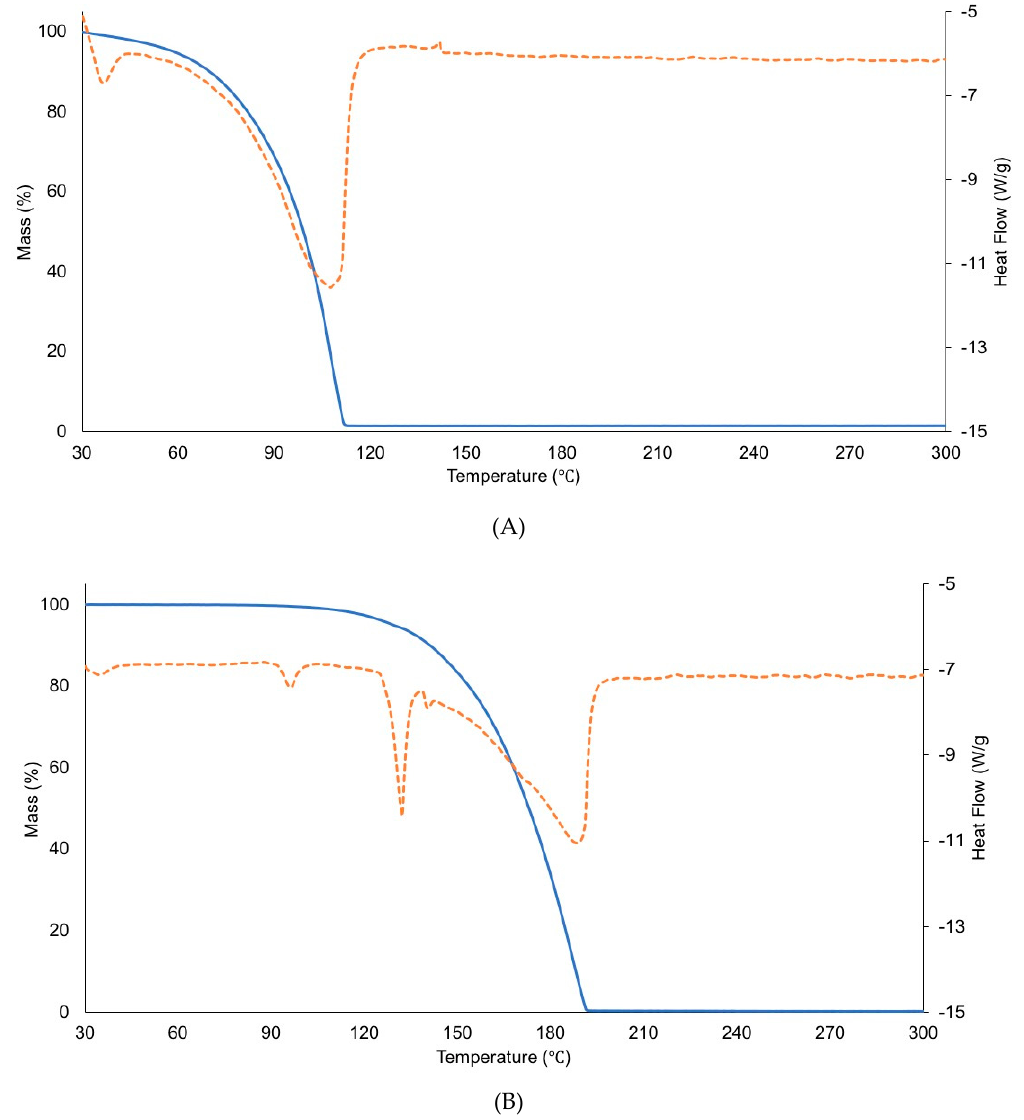
Figure 14. TGA data (solid line) overlaid with DSC analysis data (dotted line): ( A ) ammonium acetate; ( B ) ammonium TFA.